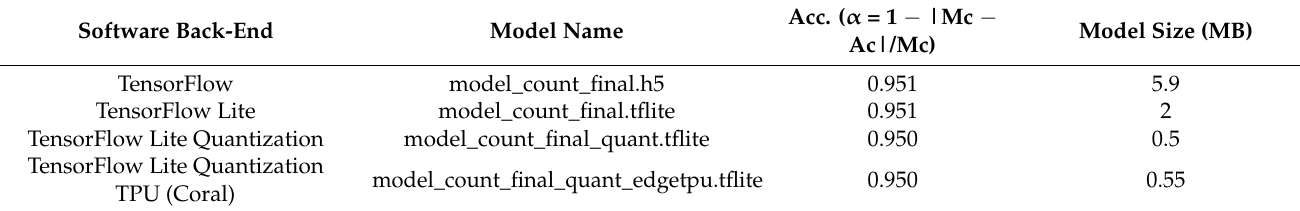
Table 2. Accuracy and model size in MB for various backends.